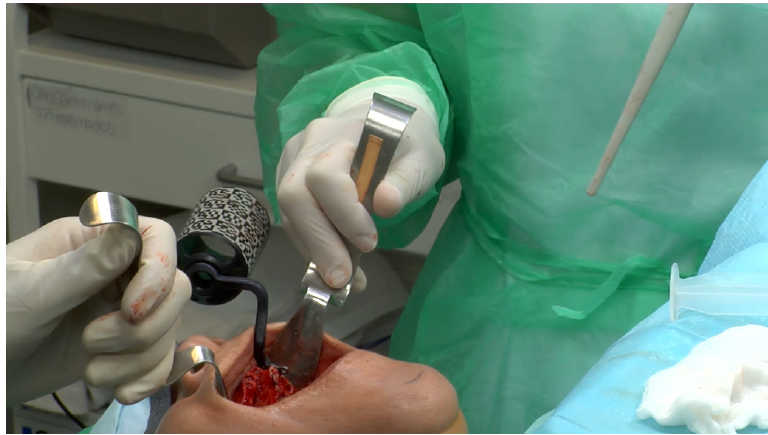
Figure 7. Perioperative photograph illustrating the fixation of the X-Guide clip receptor and array.